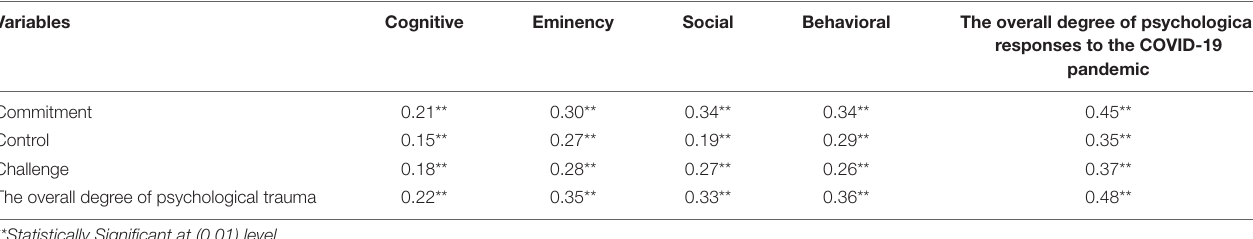
TABLE 2 | The correlation coefficient between the psychological responses of individuals to the COVID-19 pandemic and, and psychological hardiness, in a sample of Saudi society ( n = 1272).